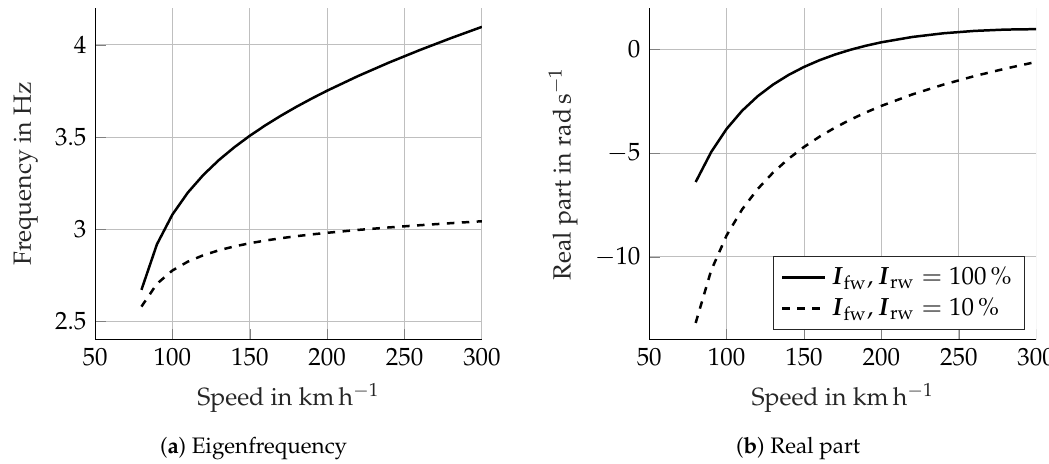
Figure 12. Comparison between the eigenvalue analysis with original wheel inertia tensors and reduced inertia tensors.